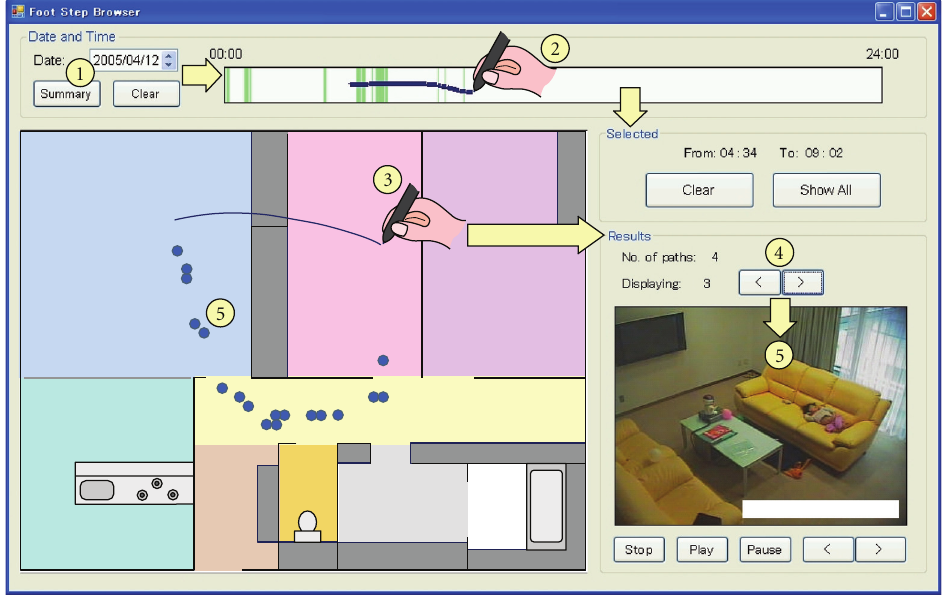
Figure 4: User interaction with system: the circled numbers 1 to 5 correspond to steps 1 to 5 described in text.